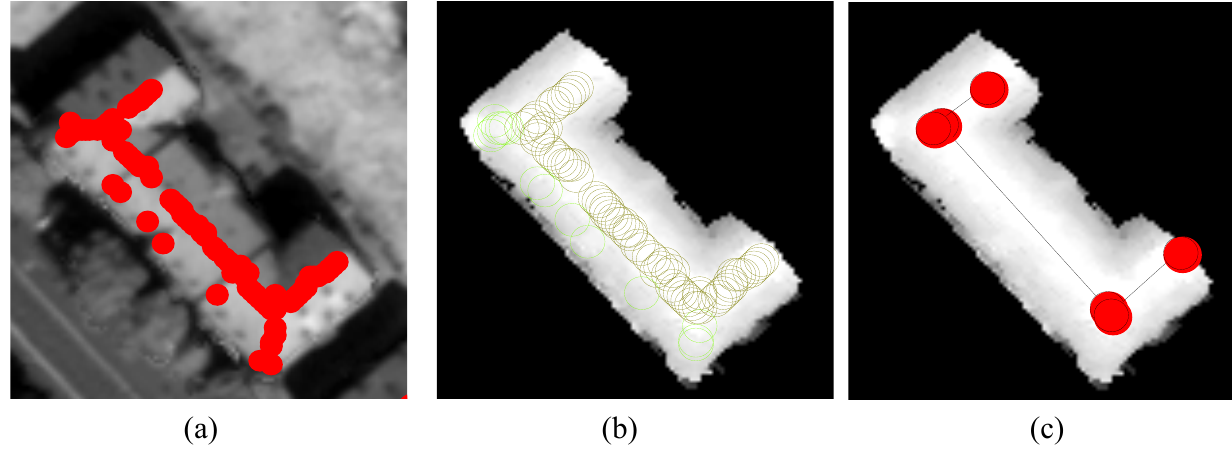
Figure 6. Ridge extraction. ( a ) Potential ridge points; ( b ) Classification of heights; ( c ) RANSAC